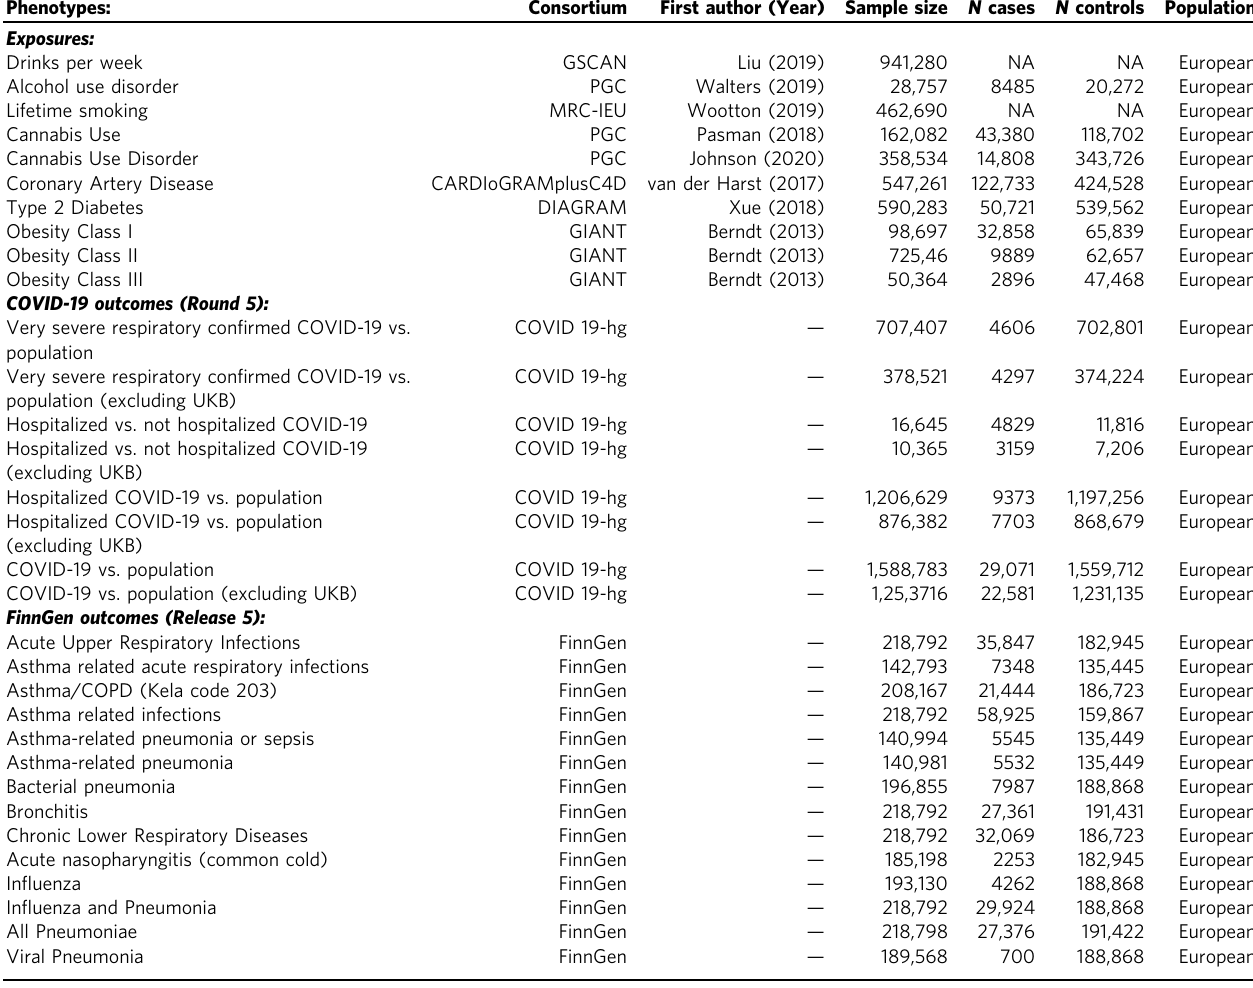
Table 6 Study data